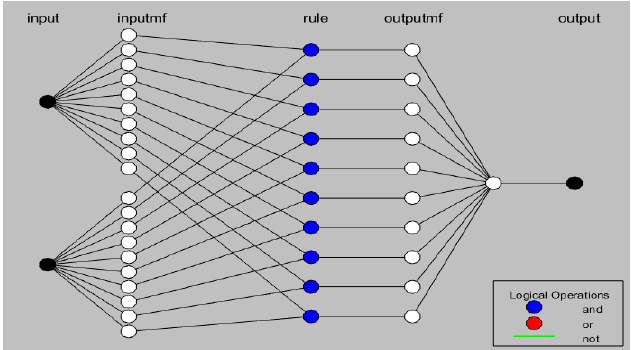
Figure 2. ANFIS structure. (It is a system-built figure, only blue dots are present as only “And” rules are used).